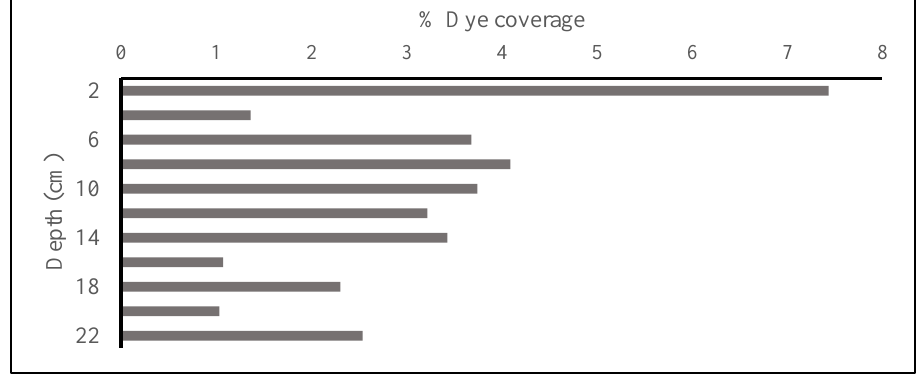
Figure 8. Depth-wise dye coverage distribution in the soil column.